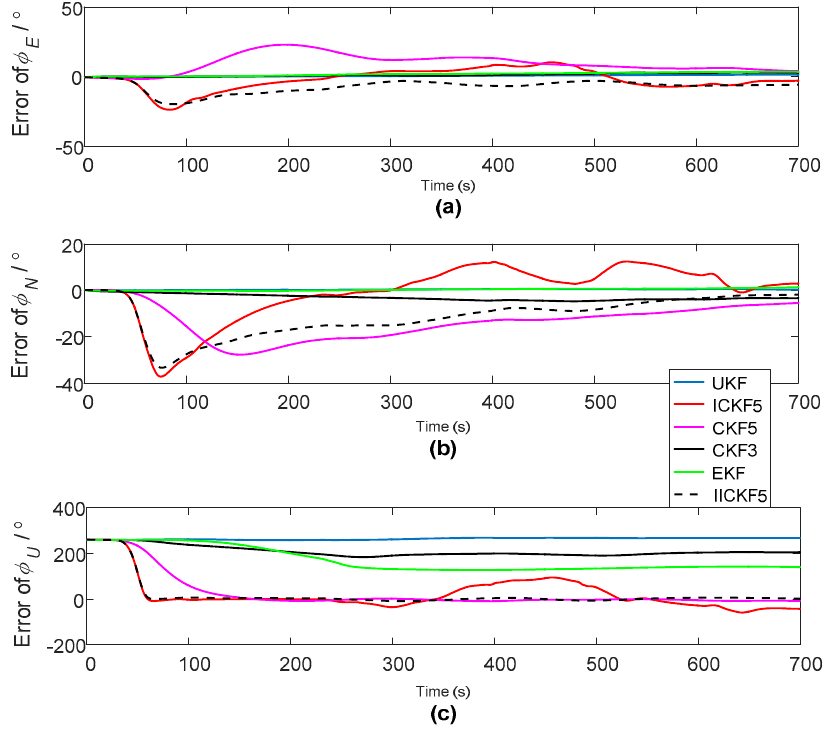
Figure 9. The alignment errors of different algorithms: ( a ) Pitch errors; ( b ) roll errors; ( c ) heading errors.